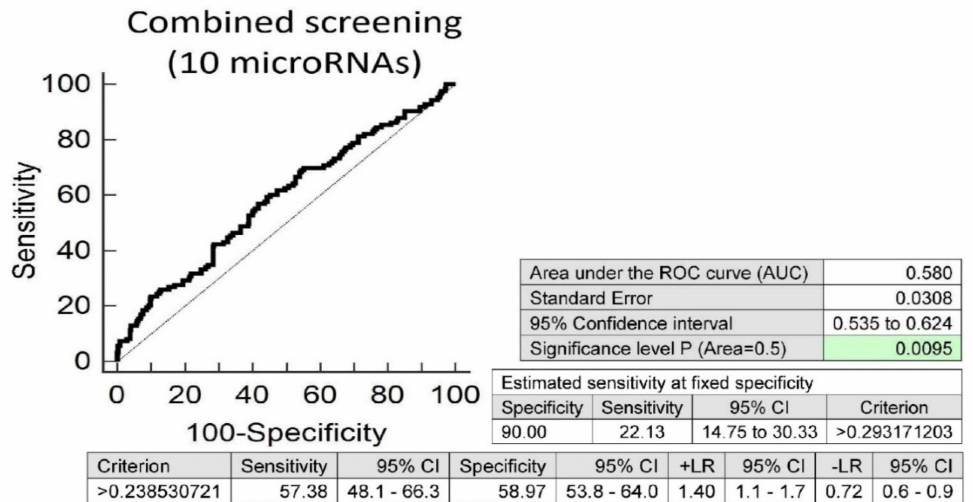
Figure 3. Aberrant microRNA expression profile in children with valve problems or heart defects, irrespective of the course of gestation of their mothers (normal and complicated pregnancies altogether). Combined screening revealed that at 10.0% FPR, 22.13% of children with valve problems or heart defects had substantially altered microRNA expression profile (miR-1-3p, miR-16-5p, miR-20a-5p, miR-21-5p, miR-125b-5p, miR-126-3p, miR-146a-5p, miR-195-5p, miR-221-3p and